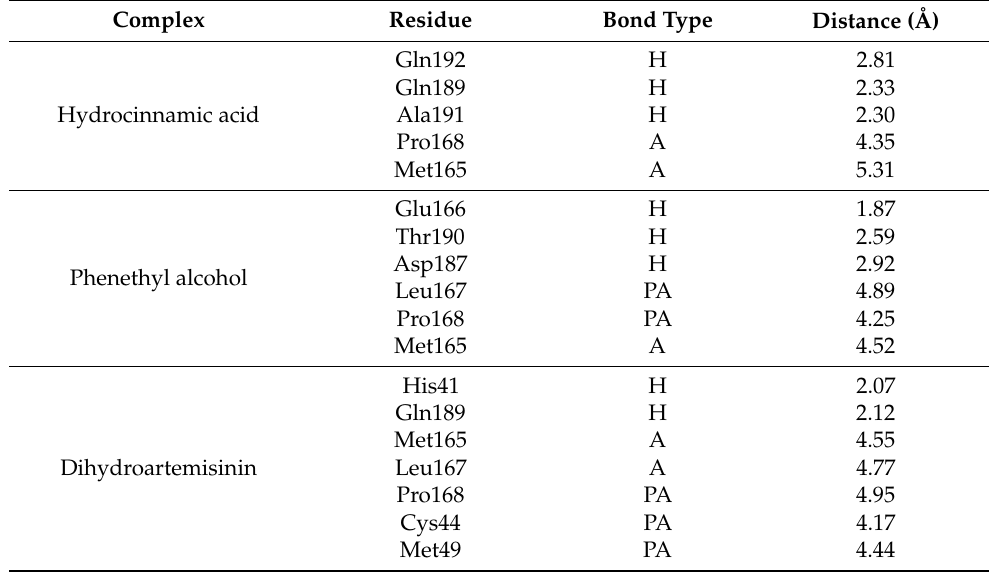
Table 3. Non-bonded interaction of the post-MD structures; here the binding residues were explored in Discovery Studio software